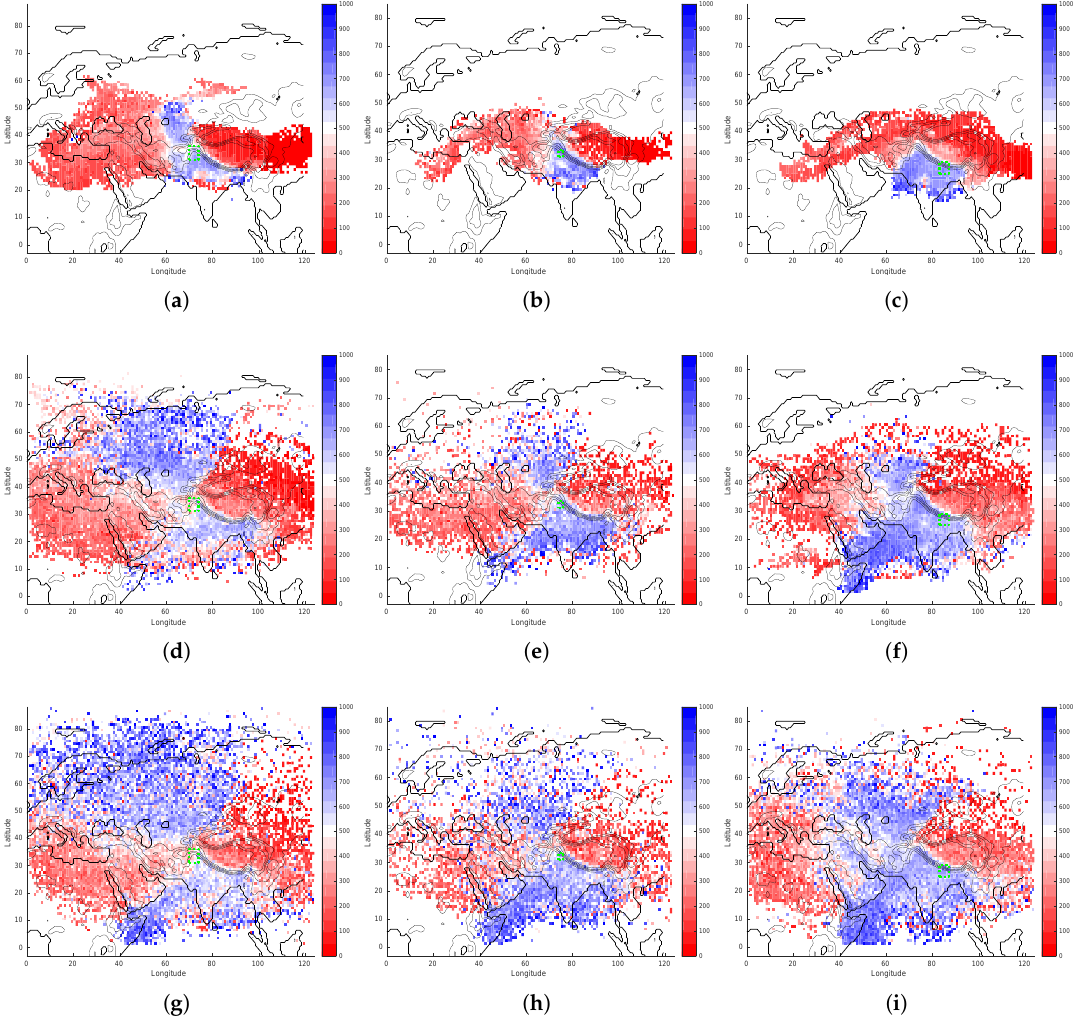
Figure 15. For the 20 strongest precipitation events for each region of interest, the parcel pressures, for all parcels over each 1 ◦ area, originating from: ( a ) NP , 2 days back in time, along the parcel trajectory; ( b ) U , 2 days back in time, along the parcel trajectory; ( c ) K , 2 days back in time, along the parcel trajectory; ( d ) NP , 6 days back in time, along the parcel trajectory; ( e ) U , 6 days back in time, along the parcel trajectory; ( f ) K , 6 days back in time, along the parcel trajectory; ( g ) NP , 10 days back in time, along the parcel trajectory; ( h ) U , 10 days back in time, along the parcel trajectory; ( i ) K , 10 days back in time, along the parcel trajectory. The area of interest is illustrated by a green dashed